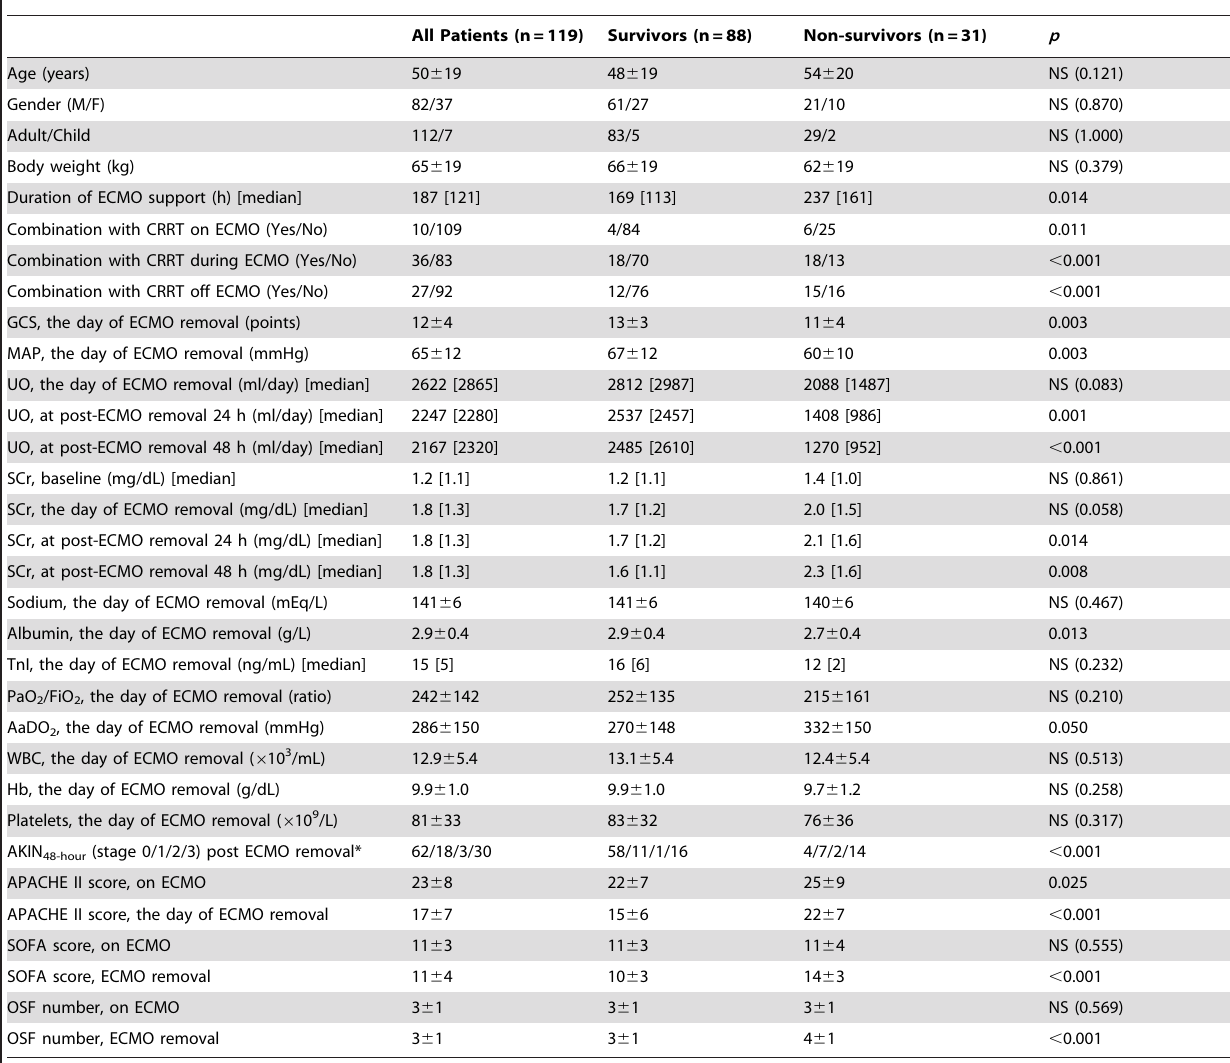
Table 1. Patients’ demographic data and clinical characteristics according to in-hospital